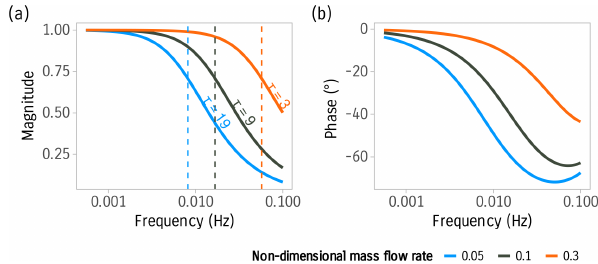
Figure 1. Frequency response for the first-order linear filter used to model the buffer volumes for three different time constants. (a) Magnitude response of the filter. Vertical dashed lines represent the cutoff frequencies for the respective time constants. (b) Phase response of the filter.